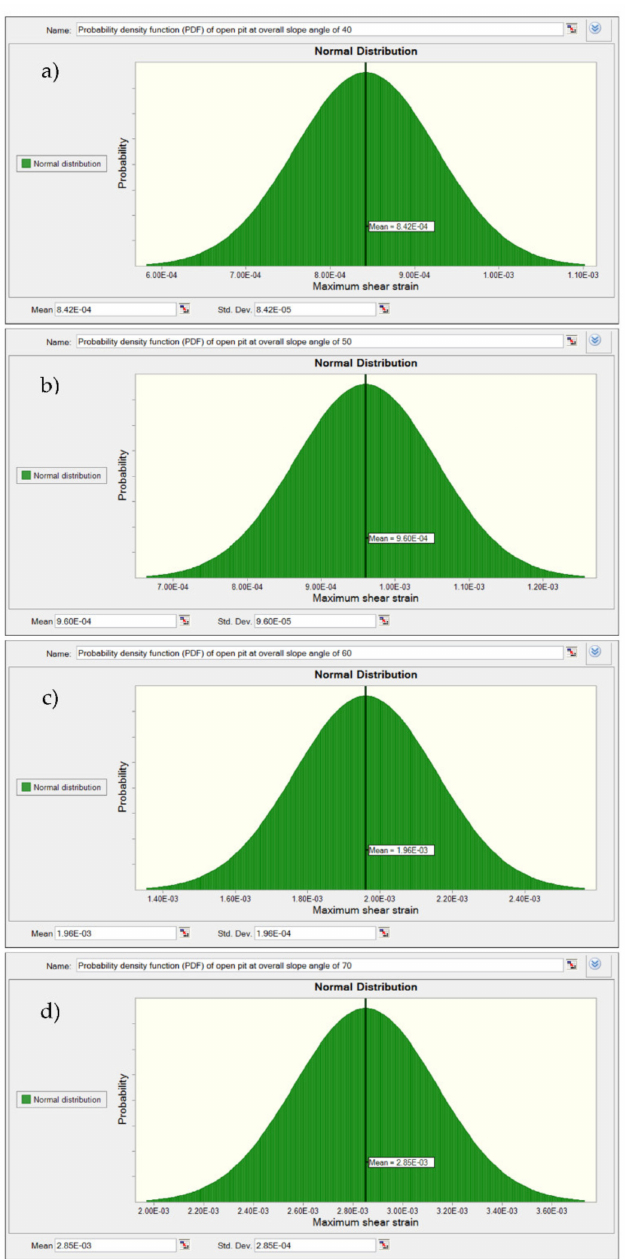
Figure 7. Probability density function (PDF) curves for maximum shear strain at different overall slope angles: ( a ) P f at overall slope angle of 40 ◦ , ( b ) P f at overall slope angle of 50 ◦ , ( c ) P f at overall slope angle of 60 ◦ and ( d ) P f at overall slope angle of 70 ◦